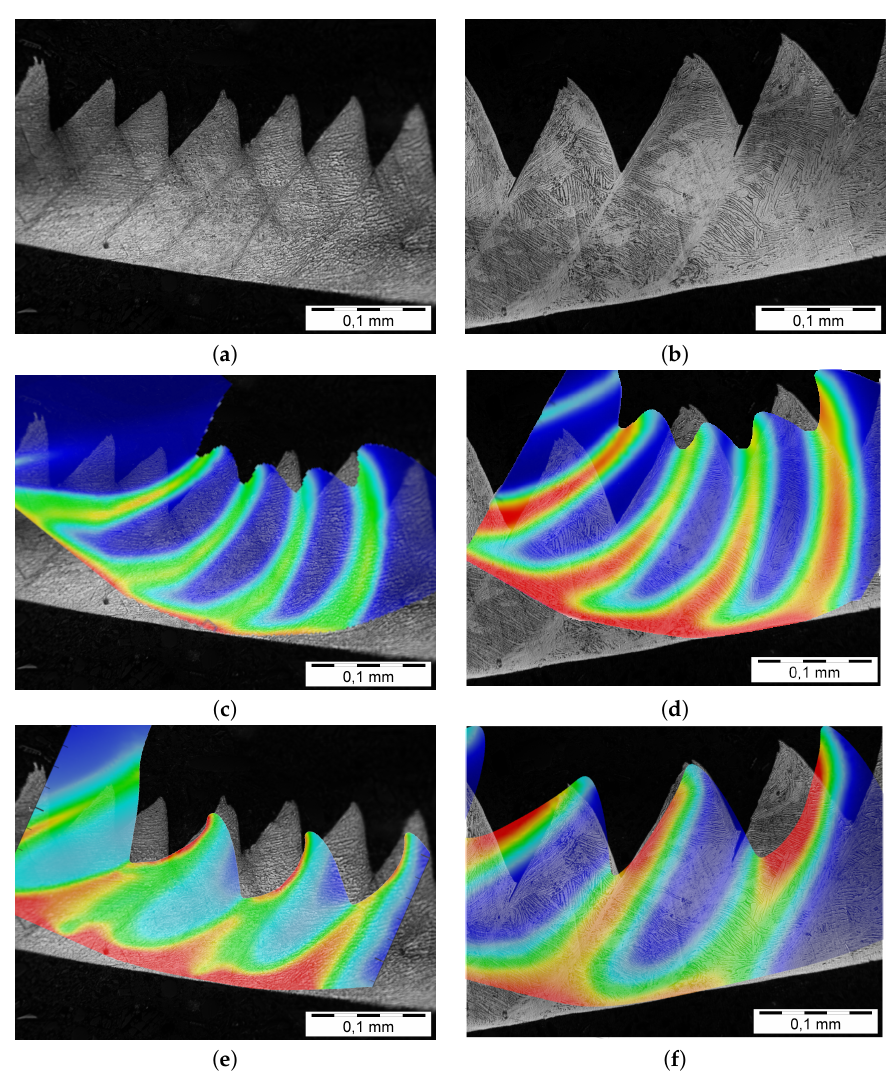
Figure 20. Optical micrographs of chip showing the adiabatic deformed shear bands of Ti6Al4V, obtained at v = 200 m/min, feed = 0.10 and 0.15 mm/rev (rake angle γ = 0 ◦ ). Superposition of FEM results after appropriate scaling. ( a ) v = 200 m/min, feed = 0.10 mm/rev; ( b ) v = 200 m/min, feed = 0.15 mm/rev; ( c ) Thermally aided shear instability; v = 200 m/min, feed = 0.10 mm/rev; ( d ) thermally aided shear instability; v = 200 m/min, feed = 0.15 mm/rev; ( e ) NCL (CDV = 0.8); v = 200 m/min, feed = 0.10 mm/rev; ( f ) NCL (CDV = 0.8); v = 200 m/min, feed = 0.15